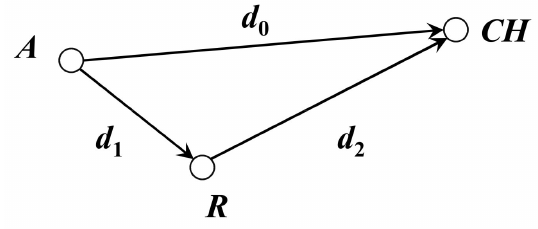
Figure 3. Node relays in a